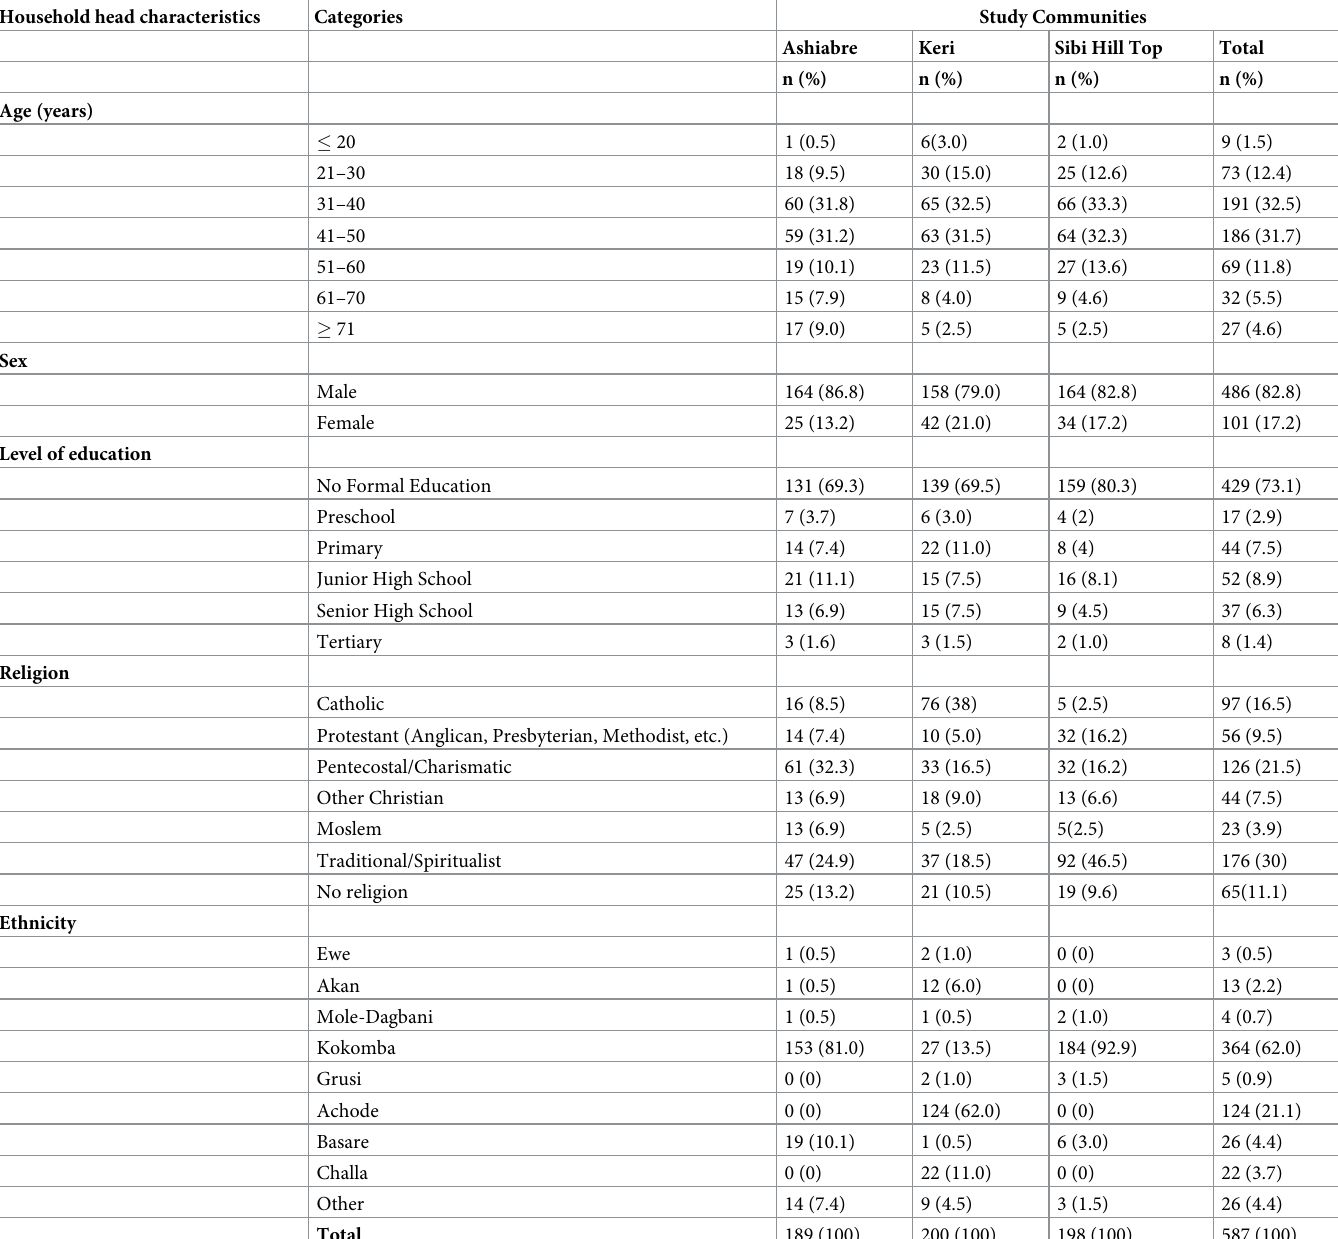
Table 1. Characteristics of the household